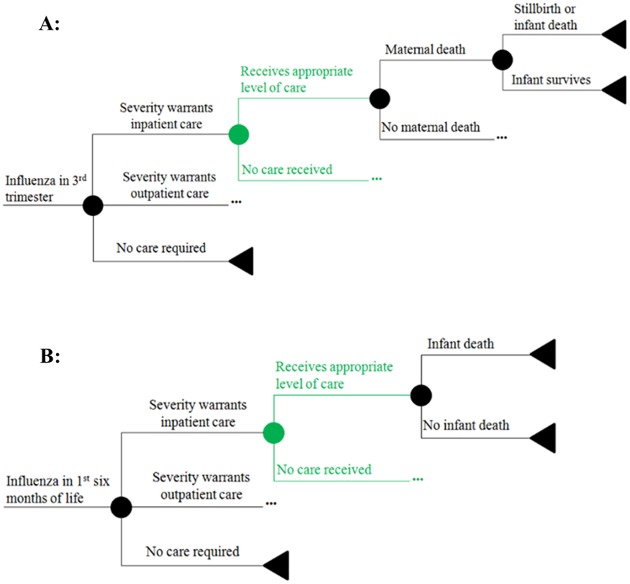
Changes to influenza sub-trees when accounting for decreased access to care.(A) Changes to the sub-tree for influenza infection during pregnancy. (B) Changes to the sub-tree for influenza infection during the first 6 months of life.